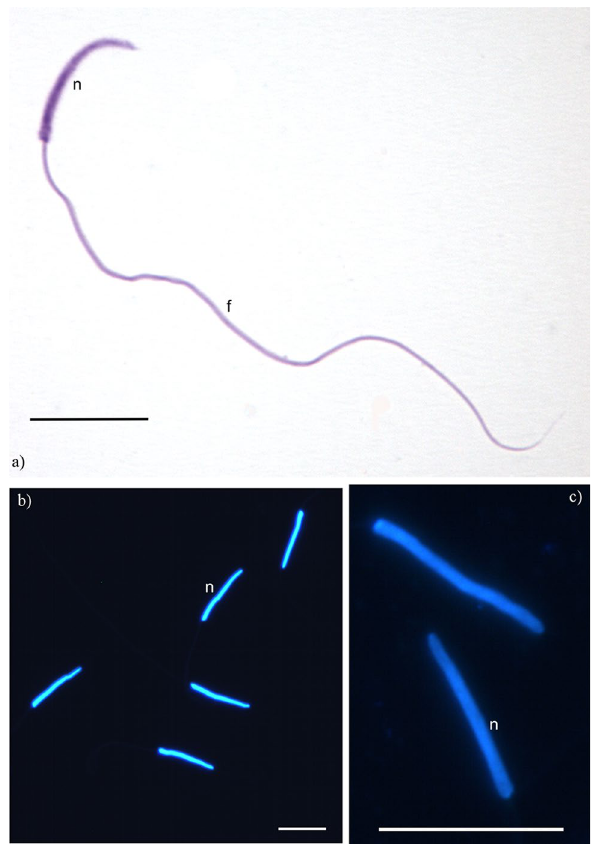
Figure 11. Morphology of the sperm of the fungus-growing ant Mycocepurus smithii . ( a ) Sperm stained with Giemsa; ( b , c ) nuclei stained with DAPI. Nucleus (n), flagellum (f). Scale bar represents 10